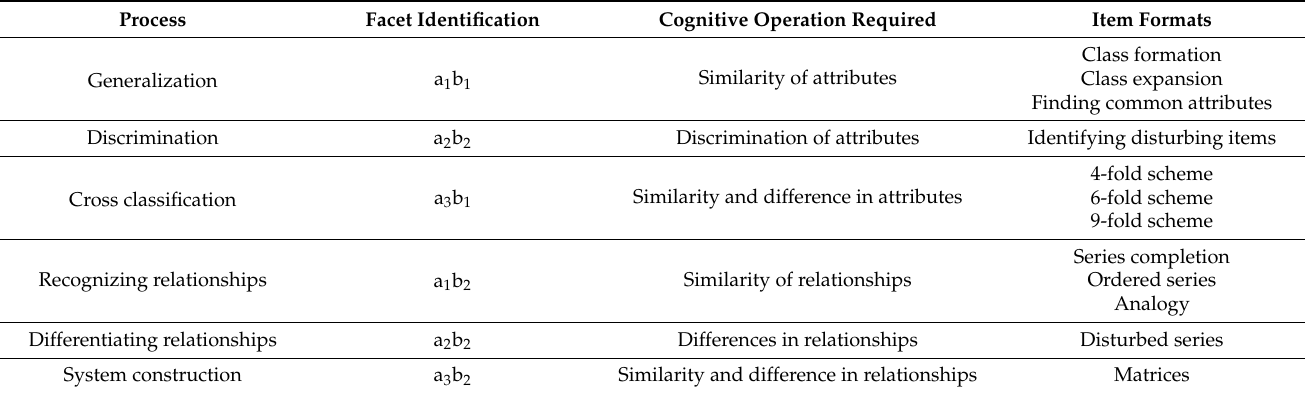
Table 1. Types of inductive reasoning problems (Klauer and Phye 2008, p.